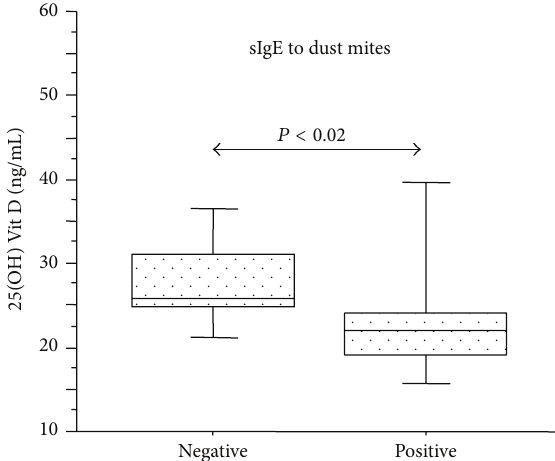
Figure 7: 25(OH) Vit D levels and sIgE to dust mites in patients with AAR ( 𝑛 = 35 ). 25(OH) Vit D concentrations were measured by ELISA in AAR patients with negative sIgE to dust mites ( 𝑛 = 14 ) and in AAR patients with positive sIgE to dust mites ( 𝑛 = 21 ). Bars in the box plots indicate (from the bottom to the top) 10th, 25th, 50th (median), 75th, and 90th percentiles. Statistical analysis was performed by Mann-Whitney U test. Significance was accepted at 𝑃 < 0.05